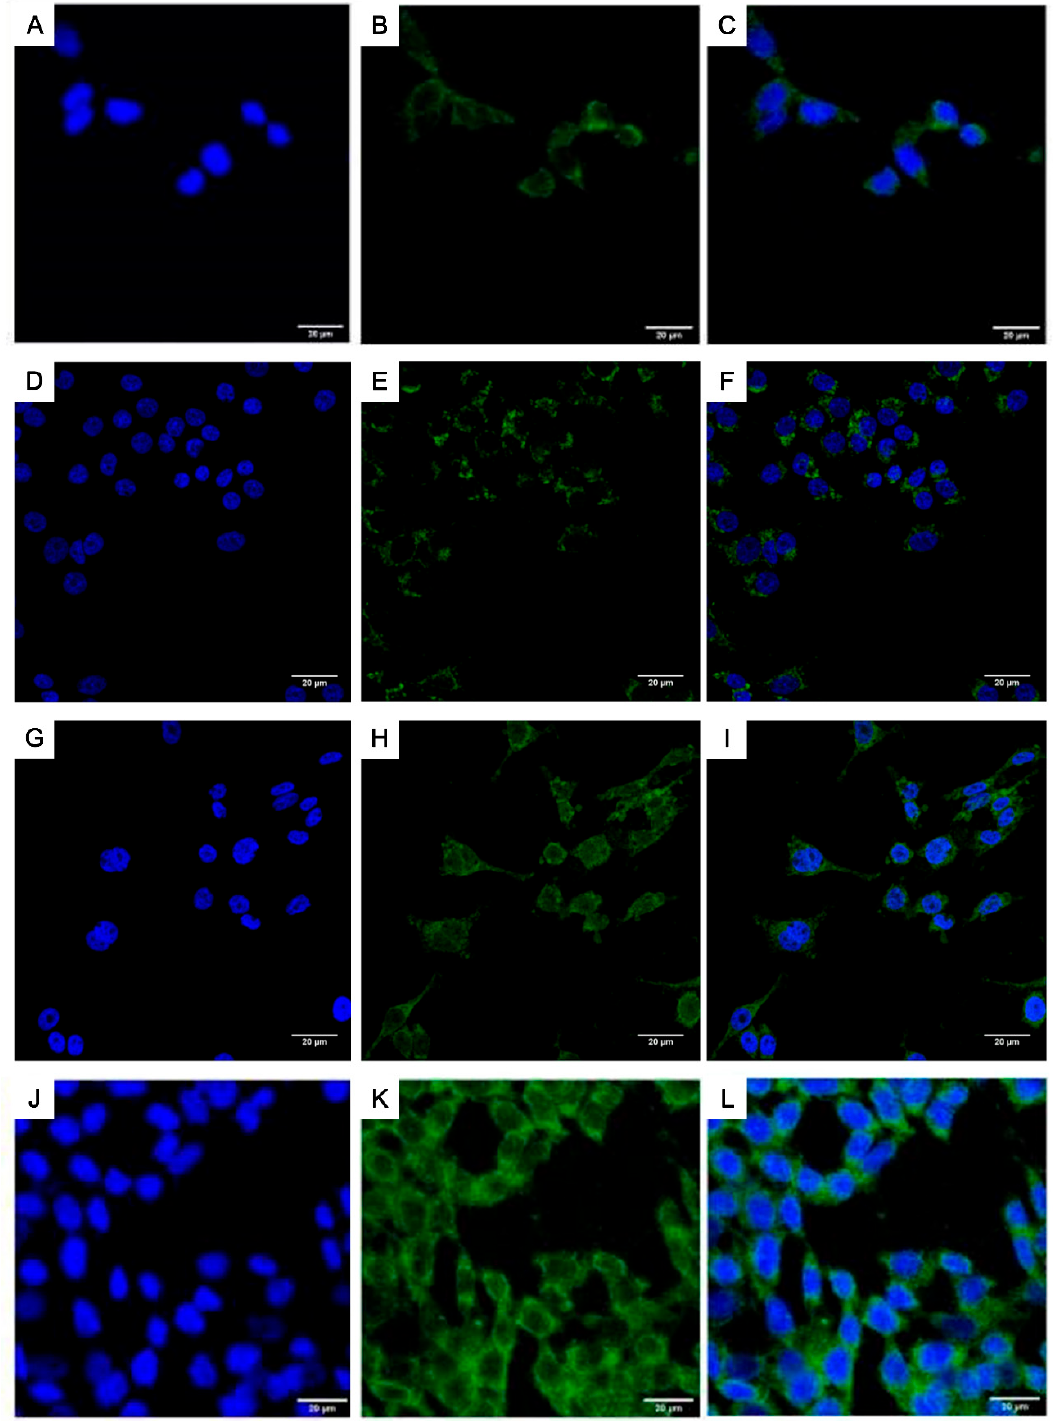
Figure 6. Folate receptors (FRs) analysis (CLSM) in LoVo cells incubated for 48 h ( A – C ) alone (control) and with ( D – F ) PEG@MNP, ( G – I ) FA-PEG@MNP and ( J – L ) FA used as a free formulation (1 µ g / mL). In A, D, G and J nuclei are stained with DAPI (blue); B, E, H and K green florescence of FRs; in C, F, I, and L a merge was made. Scale bar 20 μ m.